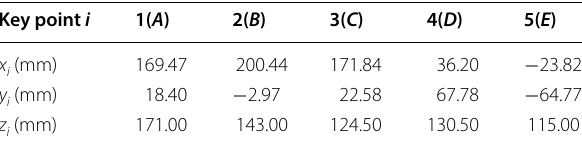
Table 1 Positions and initial rod angles of the five key points Key point i